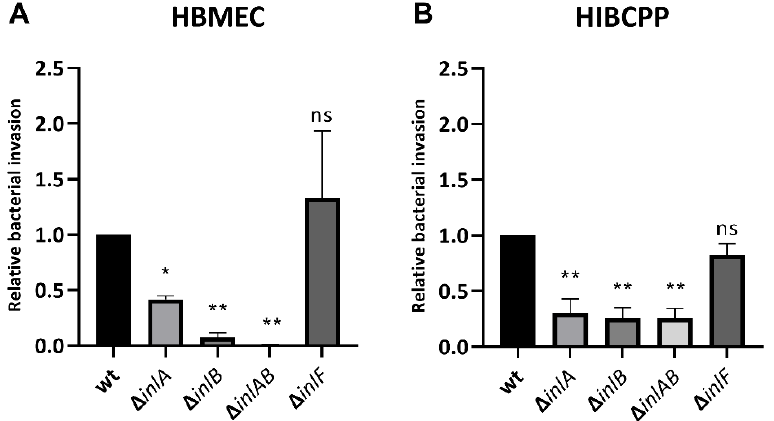
Figure 6. InlF is not required for invasion into HBMEC or HIBCPP cells. HBMEC grown in chamber slides ( A ) and HIBCPP cells grown in the inverted cell culture filter system ( B ) were then infected with wild type and the indicated mutant Lm EGD-e (MOI = 10) for 4 h. Invasion rates were determined via double immunofluorescence microscopy. Shown is the relative bacterial invasion normalized to the wild type. The results of at least 2 independent experiments performed in duplicate (HBMEC) or triplicate (HIBCPP cells) are shown. * = significant ( p < 0.05), ** = very significant ( p < 0.01), ns = not significant (significance determined in relation to the invasion of the wild-type bacte- ria).